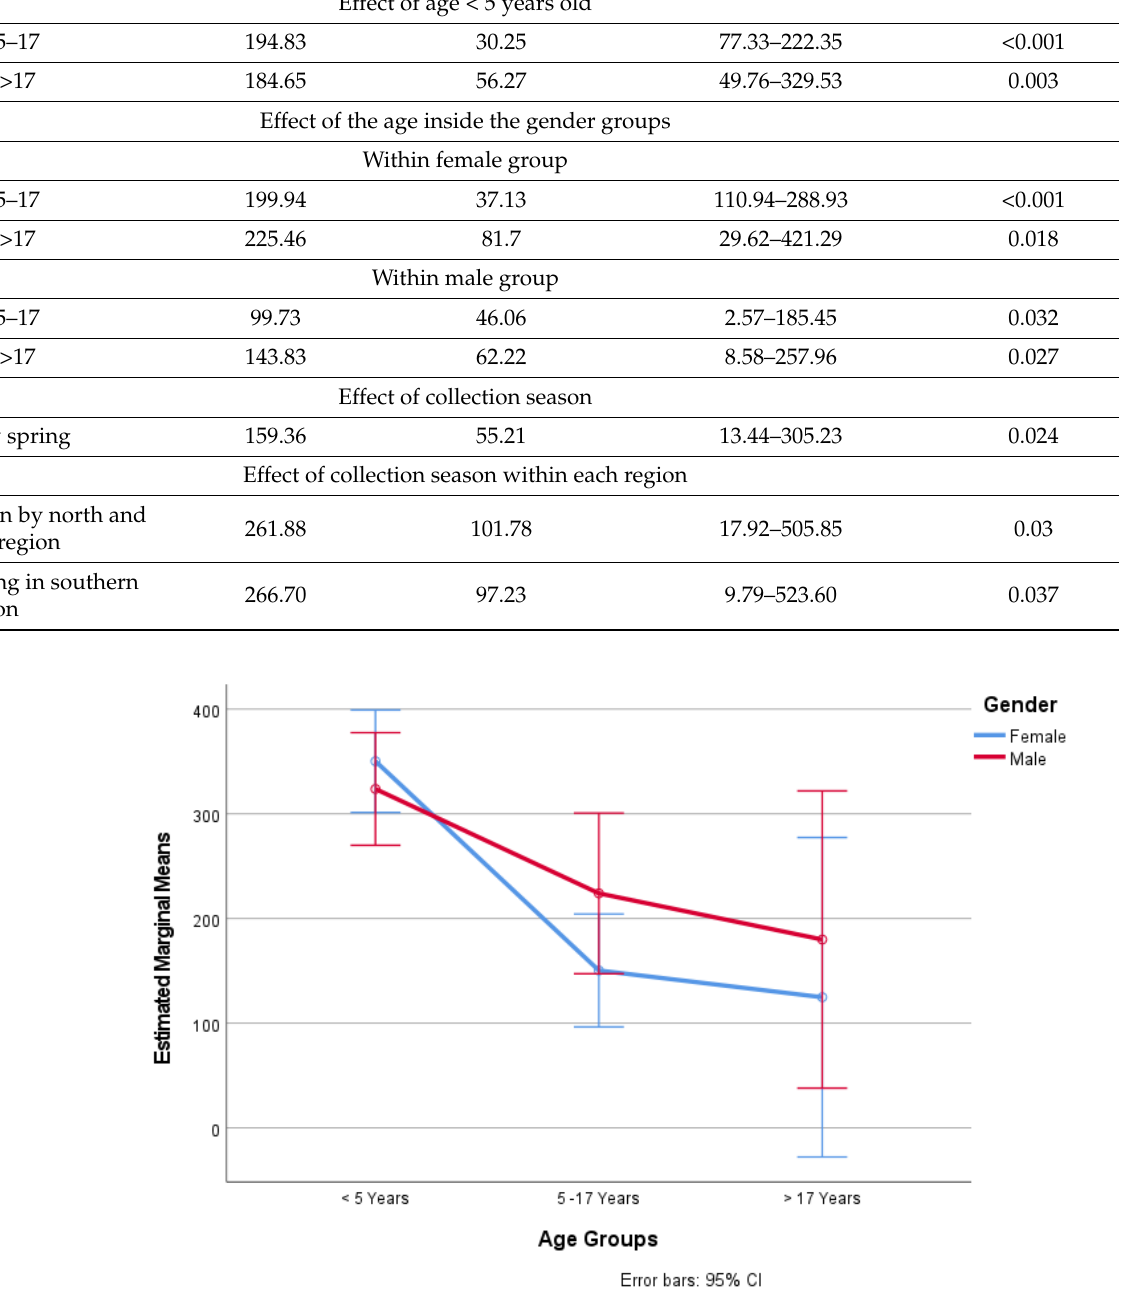
Figure 2. The estimated marginal mean strongyle egg counts for different genders and age groups. The season had a significant effect on strongyle egg shedding (F = 2.92, df = 3, p < 0.033) (Figure 3, Table 3), and approximately half of the animals were shedding strongyle eggs in different seasons (spring: 57%, both winter and autumn: 52%, summer: 48%).